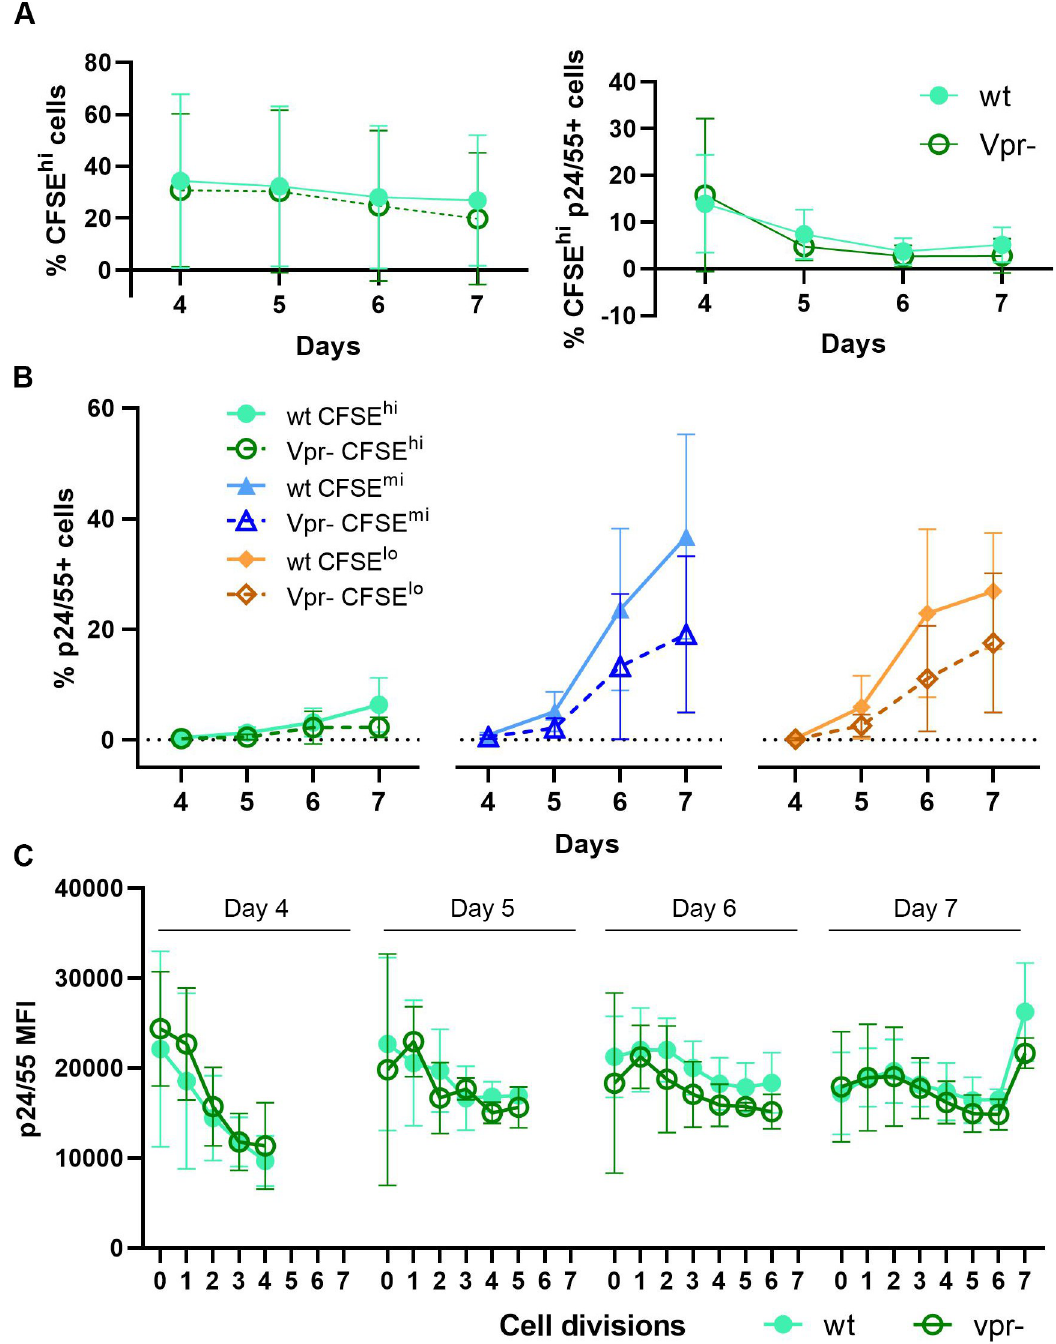
Fig 6. Potential influence of Vpr in the establishment of latent HIV infection in primary CD4 T cell cultures, following TCR stimulation. Experimental design, based on that described in Fig 5. Aliquots of isolated CD4 T cells were stained with CFSE dye, infected with isogenic HIV clones, and activated with immobilized anti-CD3 + anti-CD28 antibodies. Cell samples were infected in parallel (MOI, 0.01 IU) with wild type (wt) NL4-3 and its vpr-mutated clone (vpr - ). After 4 days of activation, the cells were removed from TCR stimulus, washed, resuspended in fresh medium supplemented with IL-2 and IL-15, and transferred to new culture plates. No antiretroviral drugs were added. Cell samples were collected daily on days 4 to 7 to evaluate HIV replication, using flow cytometric analyses with the gating strategy and identification of CFSE-stained cell subset proliferation profiles, as depicted in Fig 5A. (A) Proportions of non-dividing cells (CFSE hi ) in the infected cell population that expressed Gag (ICp24/55) were compared between the cultures infected with wild type (wt) and vpr-mutated clone (vpr - ) of NL4-3, throughout the